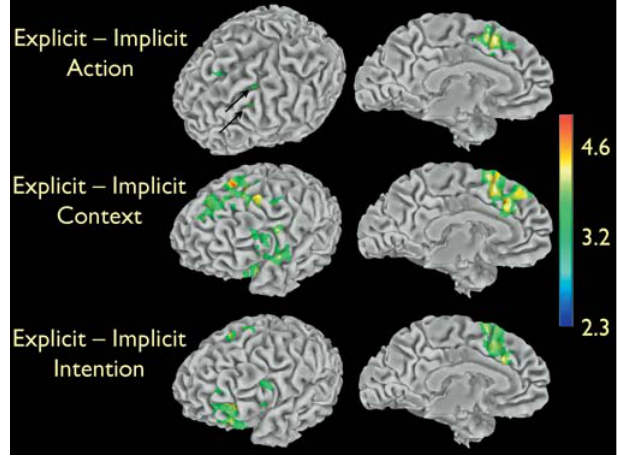
Figure 5. Significant Signal Changes in Subjects Receiving Explicit Instructions Compared to Subjects Receiving Implicit Instructions in the Three Tasks Versus Rest Threshold of Z = 2.3 at voxel level and a cluster level corrected for the whole brain at p , 0.05. The two black arrows indicate two foci of activity in dorsal premotor cortex that are located deep in the sulci and thus not easily visible on the three-dimensional surface rendering. See Tables S3–S5 for coordinates of local maxima. DOI: